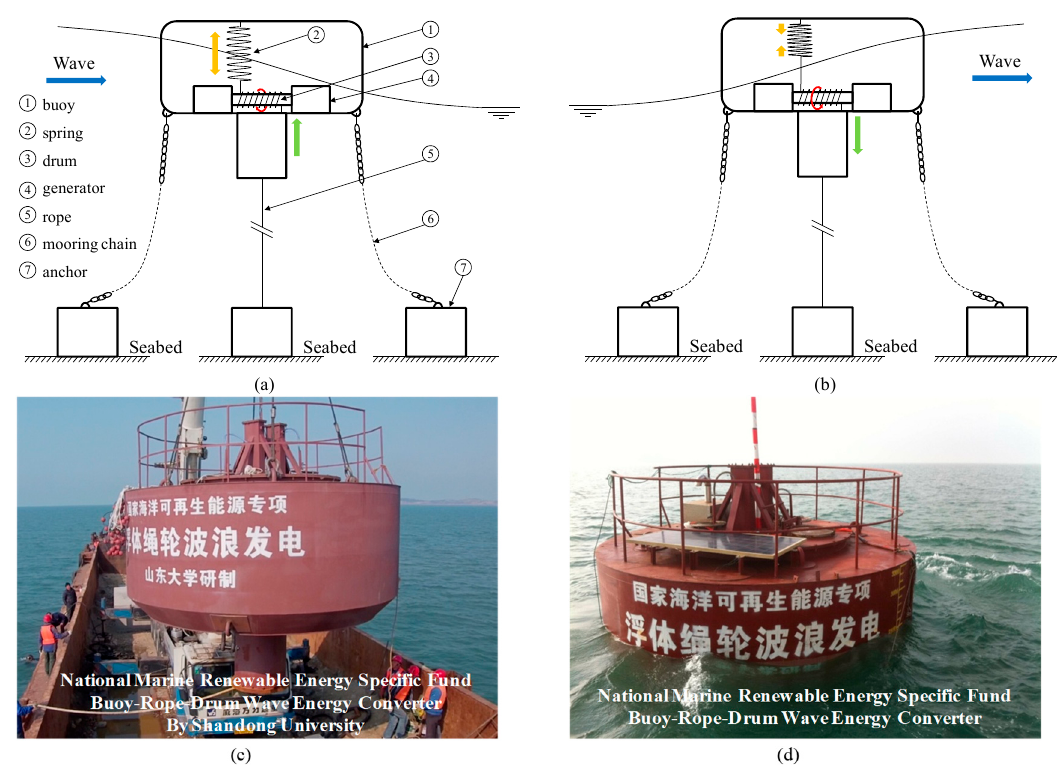
Figure 1. ( a ) Wave energy extraction stroke; ( b ) Drum repositioning stroke; ( c ) BRD WEC transportation; ( d ) BRD WEC installation [19].